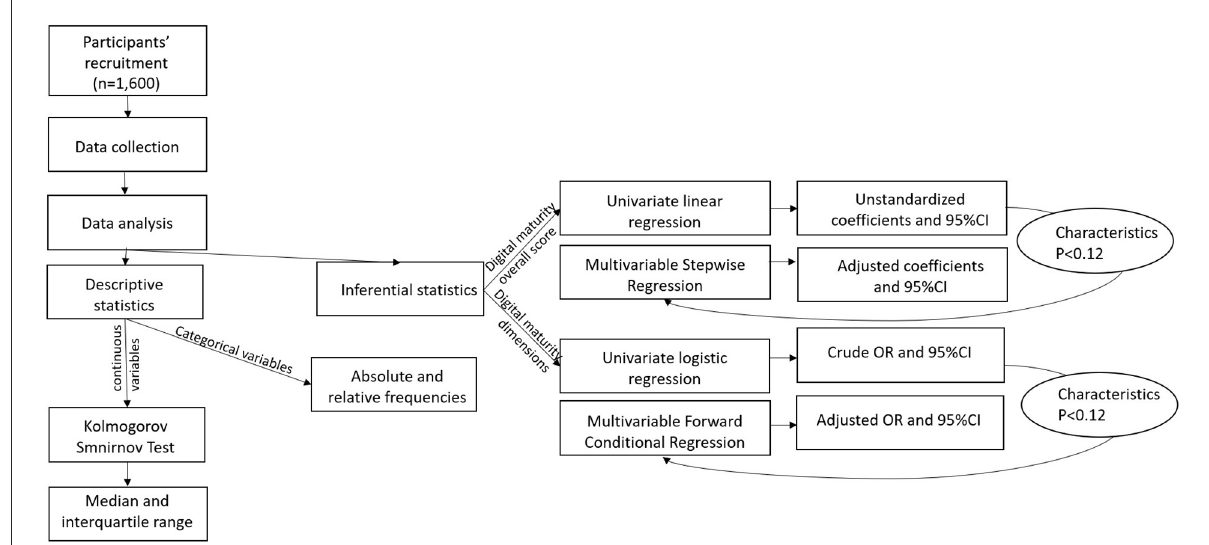
FIGURE1 Visual representation of methodology. OR, odds ratio; CI, confidence interval; characteristics P < 0.12, independent variables whose association with the dependent variable had a P -value <